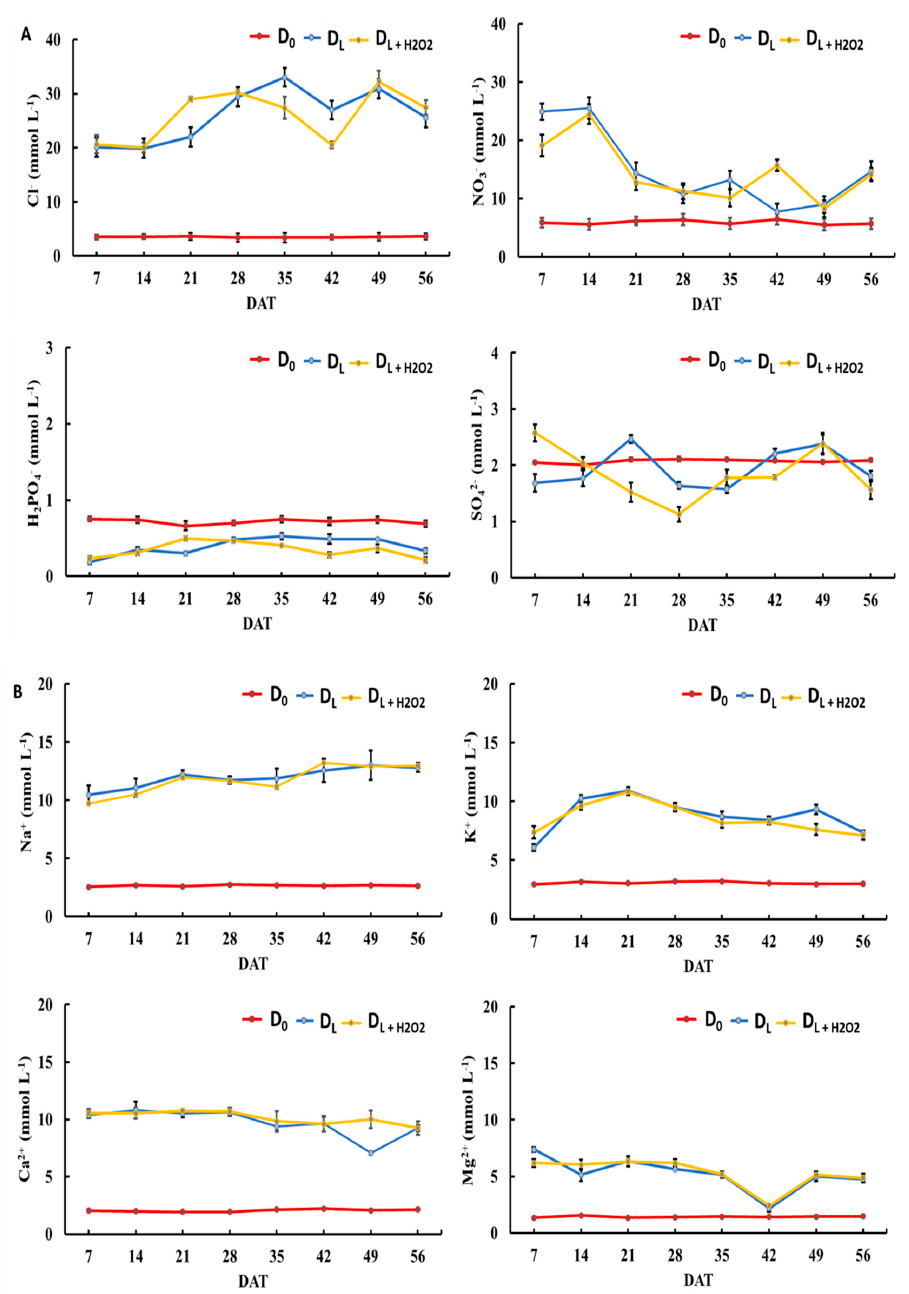
Figure 2. Anions and cations concentration ( A , B ) in the different fertigation treatments throughout the experimental period. D 0 —standard nutrient solution or control treatment, D L —raw leachate treatment and D L + H 2 O 2 —raw leachate blended with H 2 O 2 treatment. The experiment simulates a cascade cropping system with different leachate treatments of Chrysalidocarpus lutescens as primary or “donor” and Dracaena deremensis as a secondary or “acceptor” plant culture. The results are the average values ± standard deviation of four samples per fertigation treatment during the experimental period. DAT = days after transplanting.